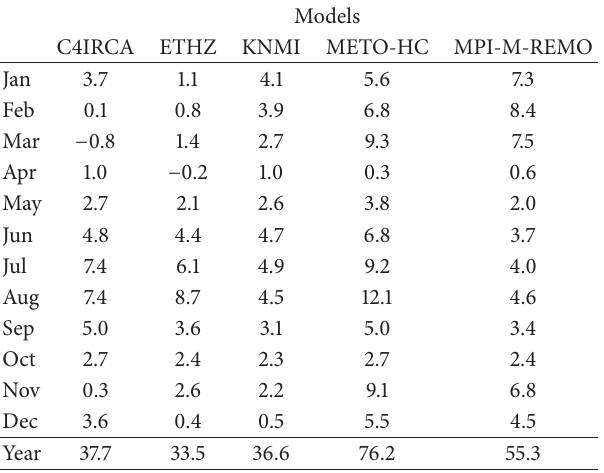
Table 10: The increases of the monthly evaporation from water bodies [in mm] in the future (2061–2090) compared to the control period 1961–1990, based on five models—example of the grid-cell of